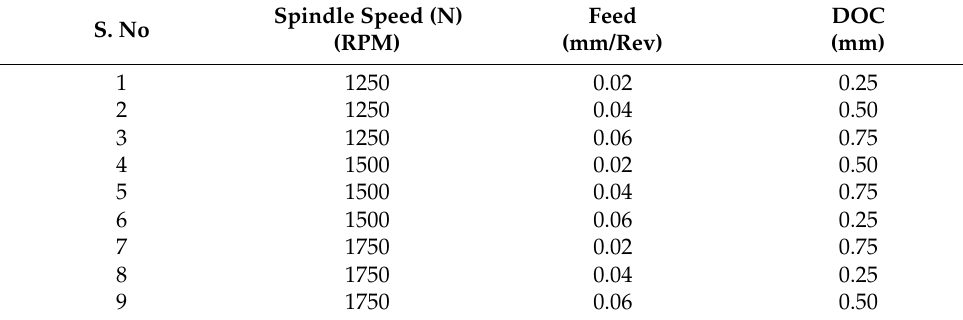
Table 4. Experimental design (L9 orthogonal array).